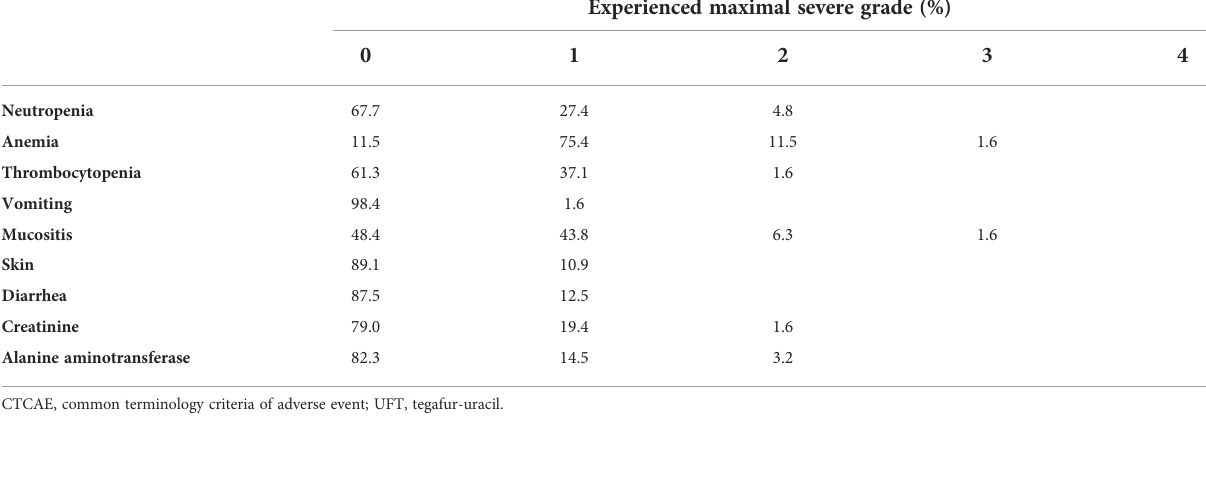
TABLE 2 Adverse events of UFT maintenance per CTCAE (n = 64).